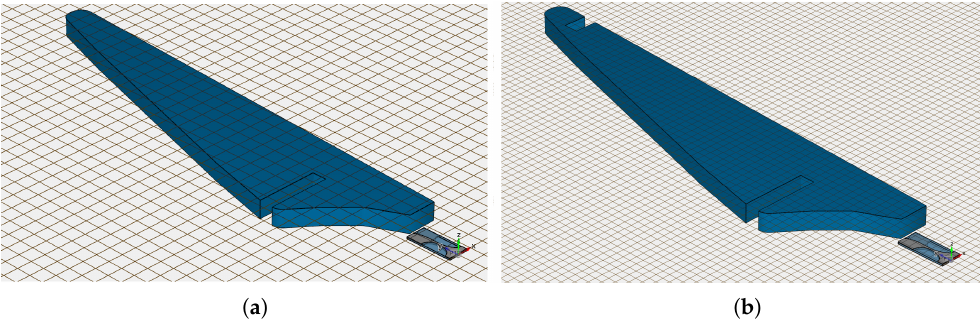
Figure 14. Simple large blades with different cracks and with an anti-dipole Vivaldi antenna: ( a ) one crack; ( b ) two cracks.